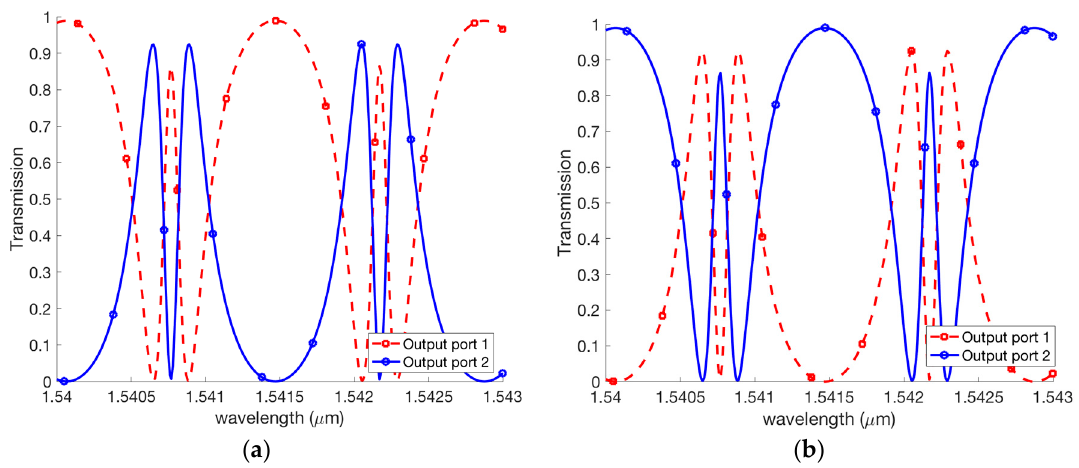
Figure 7. Transmissions of the coupled Fano resonances for Figure 5b with input signal is presented at ( a ) input port 1 and ( b ) input port 2.